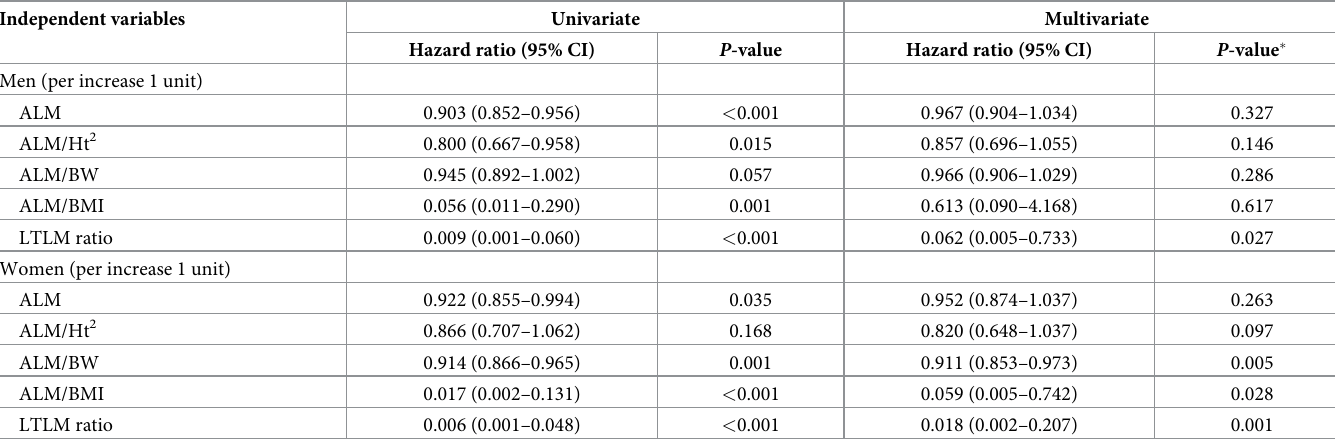
Table 3. Univariate and multivariate hazard ratios for all-cause mortality according to various indices. Independent variables Univariate